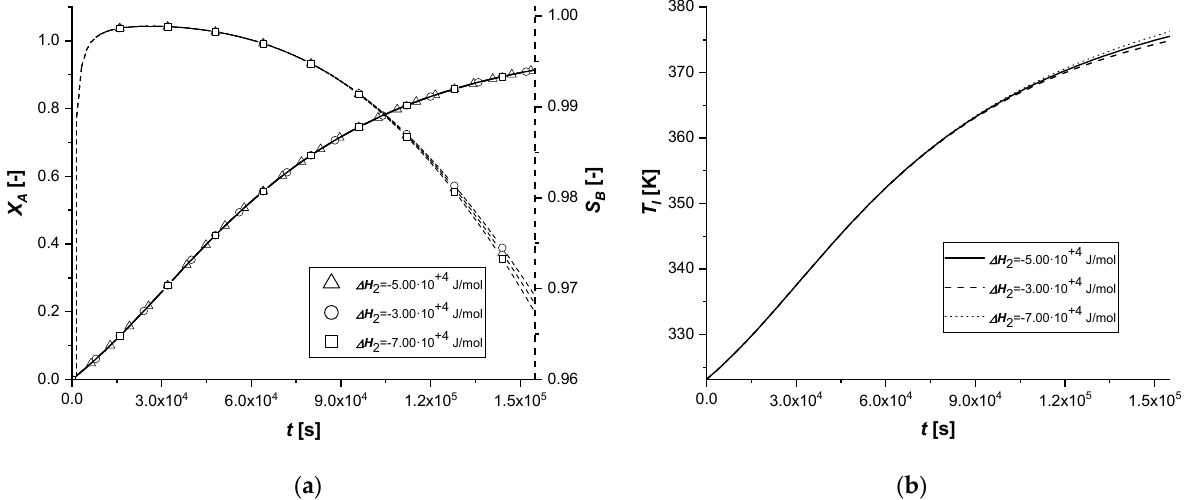
Figure 10. EY Δ rH 2 investigation. ( a ) Bulk profiles over time of X A and S B . ( b ) Bulk profile of T l over time. As can be seen from Figure 10, the variation of Δ H 2 obtained starting from the same values used in the study of Δ H 2 , led to completely different results. Both the solid-side and liquid-side profiles overlap almost completely in all the cases showing slight devia- tions from the standard behavior only in the production of C in the EW and EY cases. As anticipated, the energy contribution provided is very limited due to the low concentration of C produced. In cases where the catalytically active phase is positioned in the innermost parts of the particle, the reactive thrust is displayed in a slightly more evident way, but the effect of the parameter remains extremely limited. 3.2.2. Reaction Rate Constants The manipulation of the reference kinetic constant of the first reactive process deter- mines the variation of its reaction rate. Consequently, an increase in the amount of reac- tant diffused in the particle or an improvement in the production of the intermediate can be expected. The comparison between the solid side and liquid side concentration profiles calcu- lated for all the catalytic cases are reported in Supplementary Materials in Figures S19– S27. The details of each conversion, selectivity, and liquid side temperature profiles are displayed in Figures 11–13.